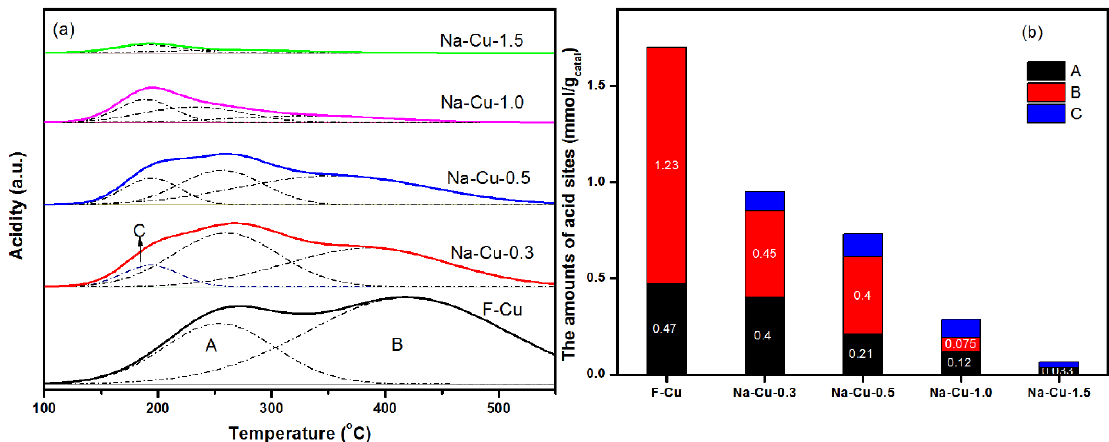
Figure 2. NH 3 -TPD results ( a ) and acidity ( b ) of fresh and Na-impregnated catalysts. The reaction was carried out with a feed containing 500 ppm NH 3 , balance N 2 , and with GHSV = 80,000 h −1 .